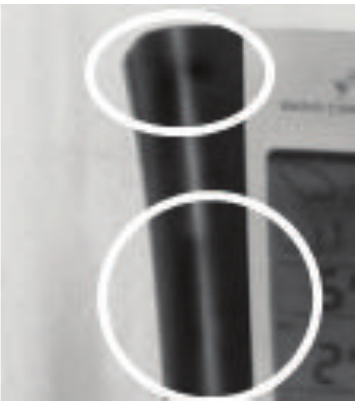
Figure 8: Example of “lake”—the color of this area is significantly di ff erent from the respective colors of input images.